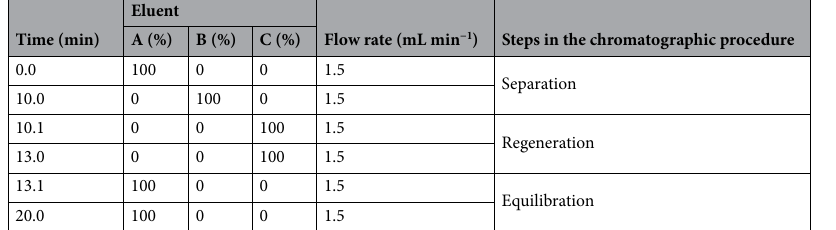
Table 2. Chromatographic program for separation of chromate, molybdate and arsenate on the anion- exchange HPLC Mono Q column. Eluent A: MilliQ water. Eluent B: 0.7 mol L −1 NaCl. Eluent C: 2 mol L −1